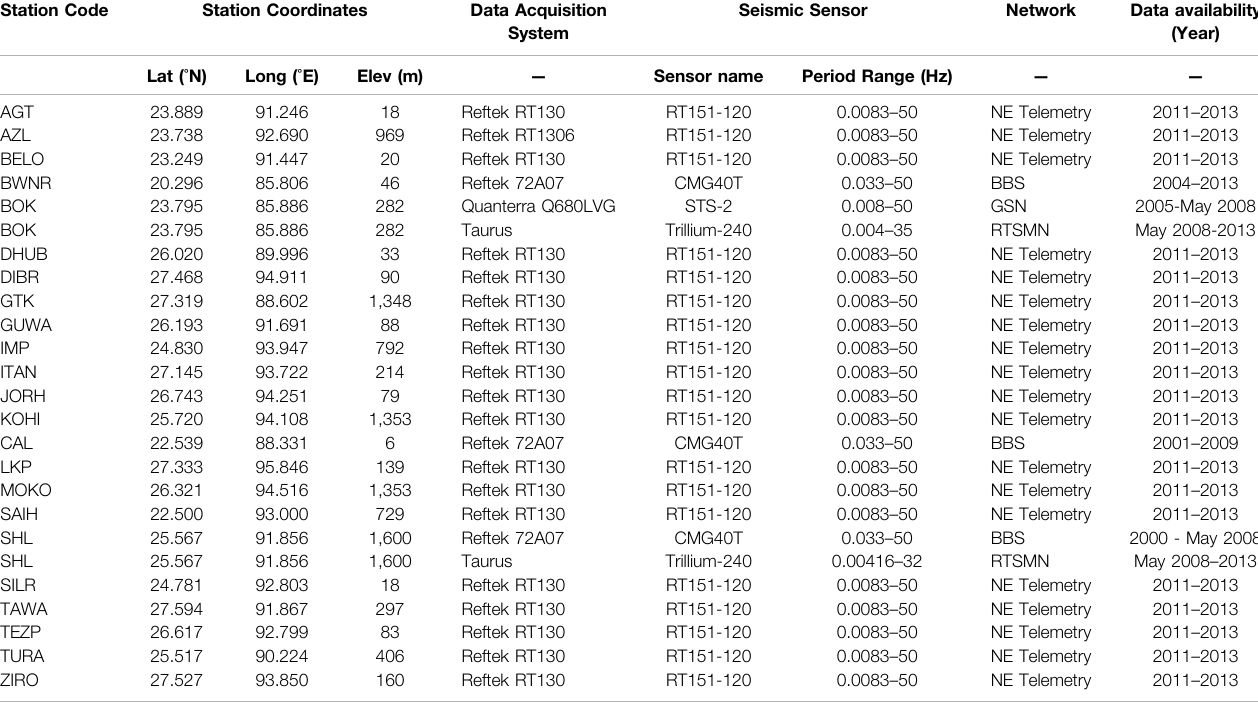
TABLE 1 | Detail information of seismic stations.